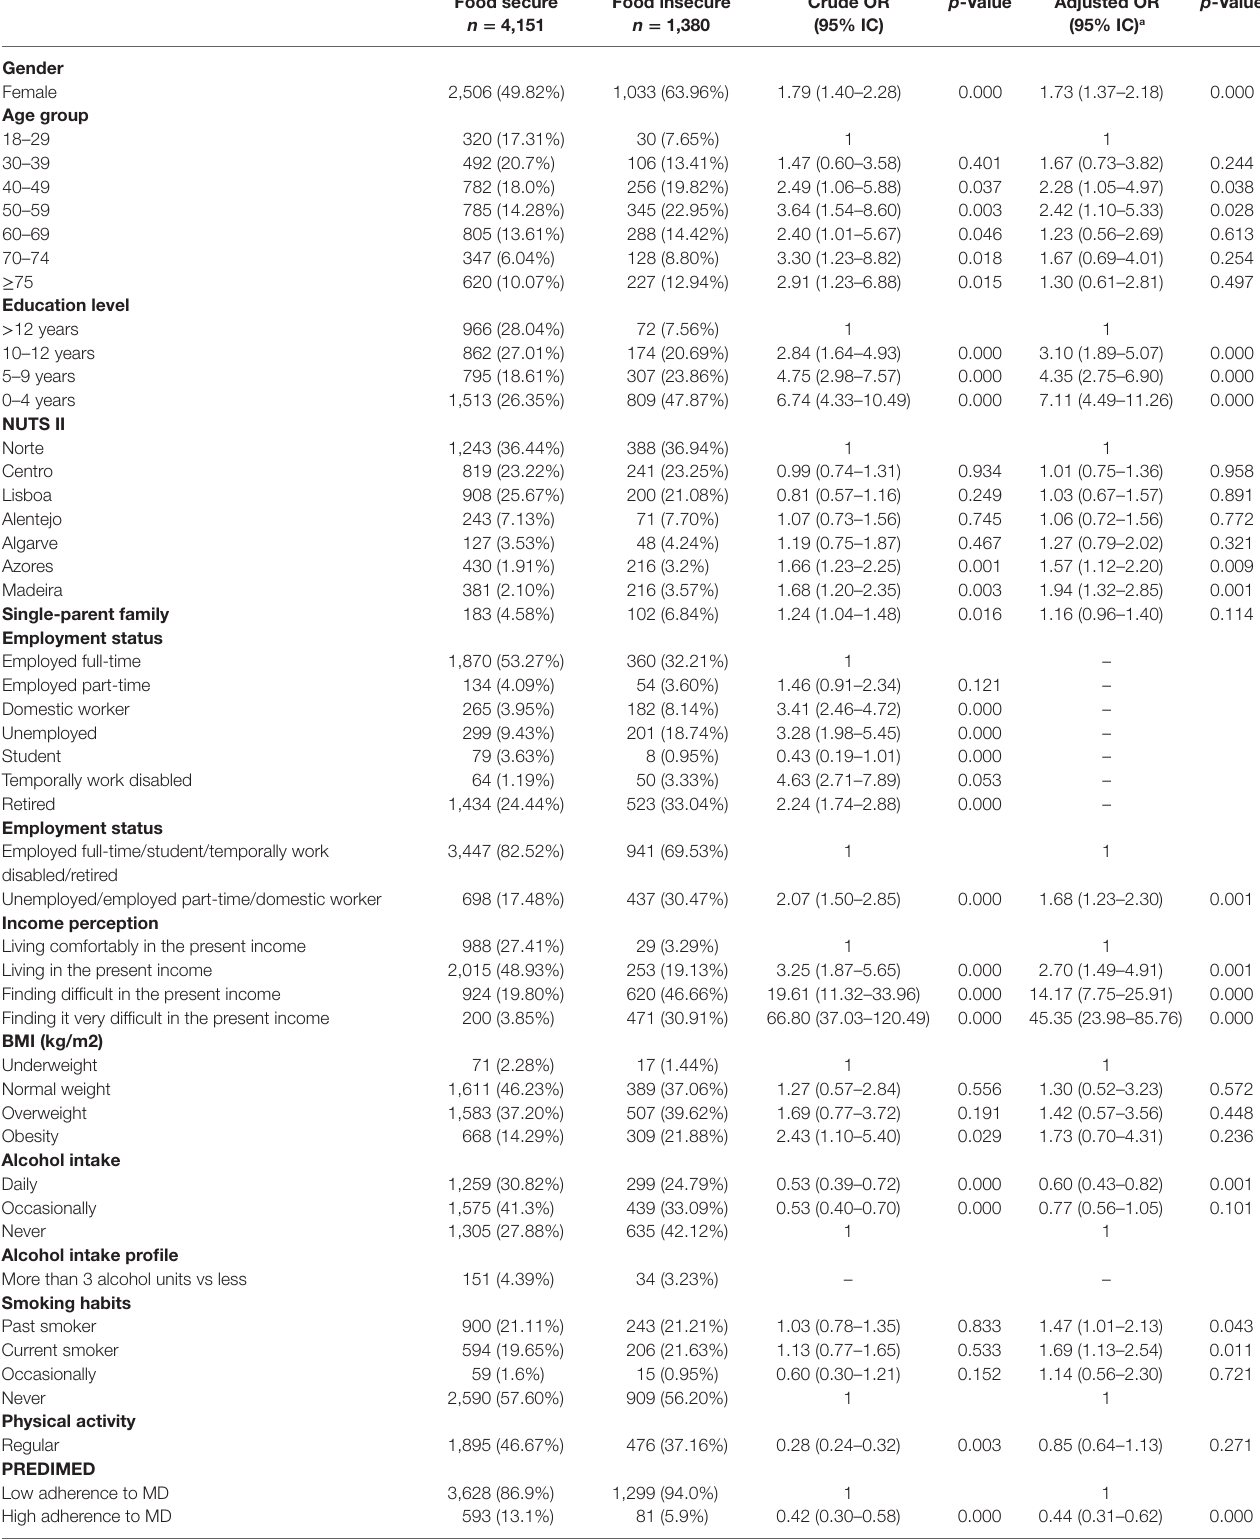
TaBle 2 | Comparison of sociodemographic, socioeconomic, lifestyles characteristics, and Mediterranean diet (MD) characteristics between households with and without food